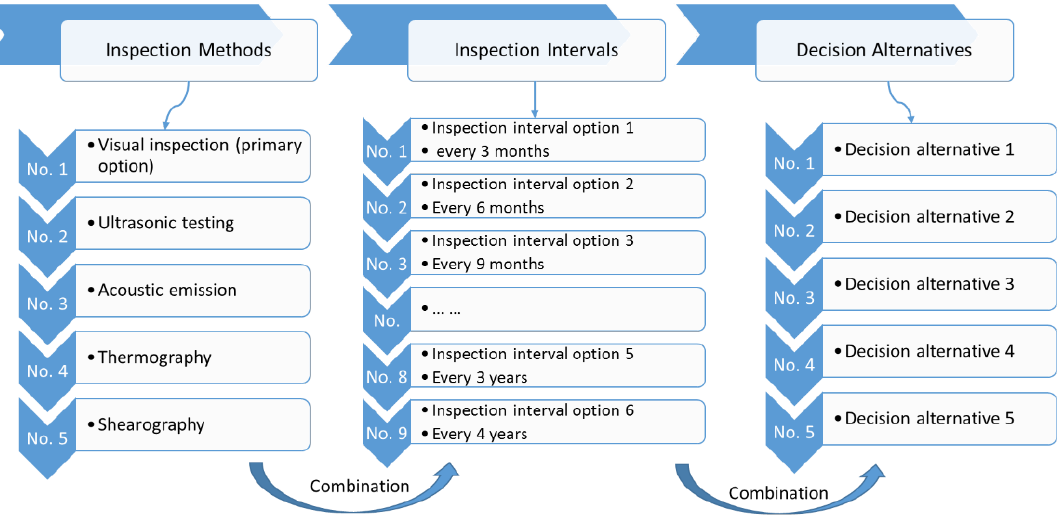
Figure 3. Illustration of condition-based maintenance procedure.